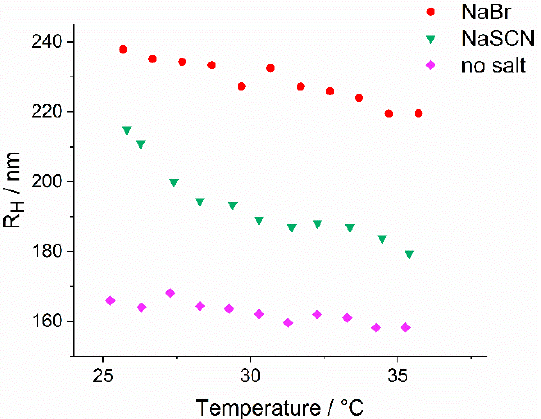
Figure 10. The effect of NaBr or NaSCN on the hydrodynamic radii evolution of P(DMA 35 - NIPAM 212 )-PS 1089141 (c = 0.02% ( w / w )) as a function of temperature determined by DLS measurements. The micellar dispersions were heated from 25 °C to 35 °C. The concentration of the sodium salt solutions was 0.5 M in all measurements.